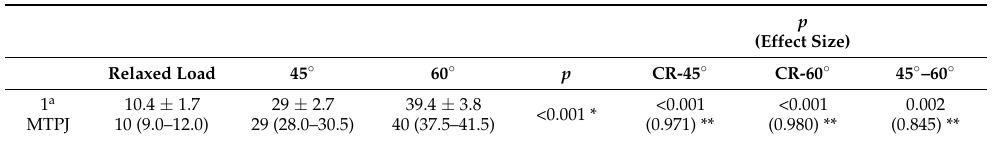
Table 4. Analysis of the evolution of the variable in the radiographic measurements. * ANOVA of repeated measures. ** Large effect size. 1 a :